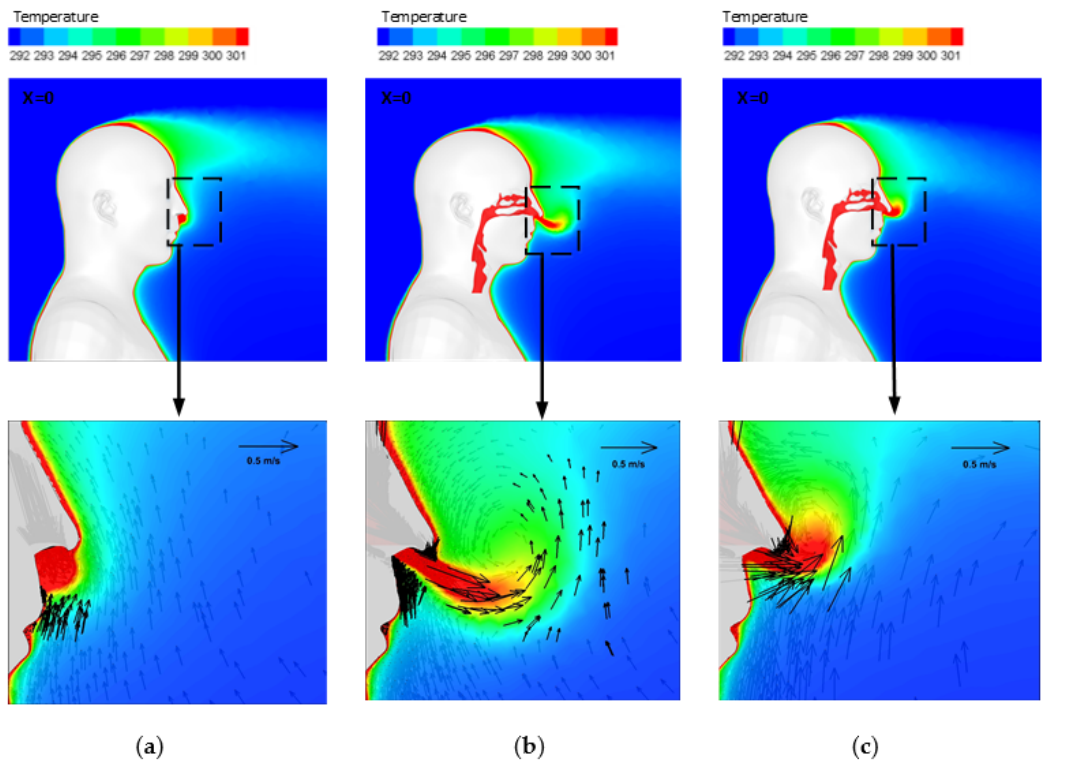
Figure 6. Air temperature program and local vector diagram of the left human head in X = 0 plane under different conditions: ( a ) V in = 1 m/s, T = 291 K, NCA; ( b ) V in = 1 m/s, T = 291 K, CA; ( c ) V in = 2 m/s, T = 291 K, CA.